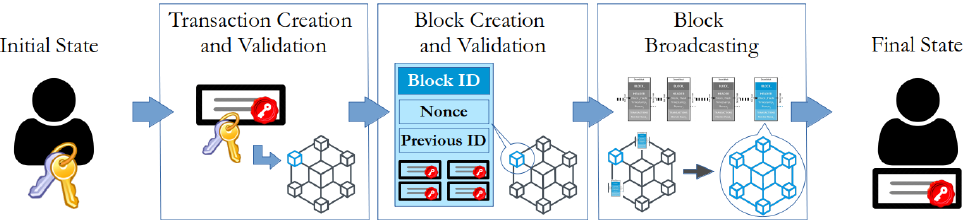
Figure 1. Flowchart of the blockchain